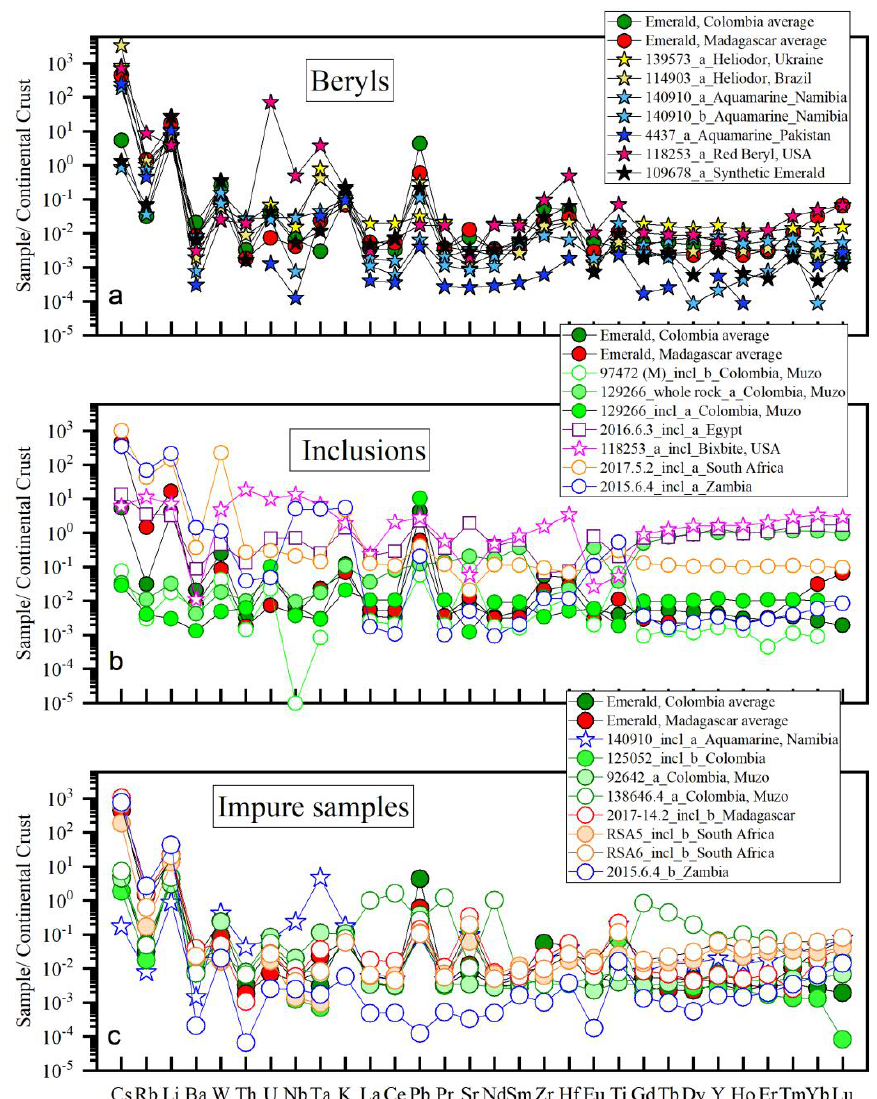
Figure 5. ( a ) Incompatible trace element pattern for other colored beryls and synthetic emerald; ( b ) incompatible trace element pattern for pure inclusions and ( c ) incompatible trace element pattern for impure emeralds (impure samples). Shown for comparison are the pure compositions of type IIB (Colombia) and IA (Malagasy) emeralds. Elements are ordered by relative incompatibility and normalized to continental crust composition [28] .